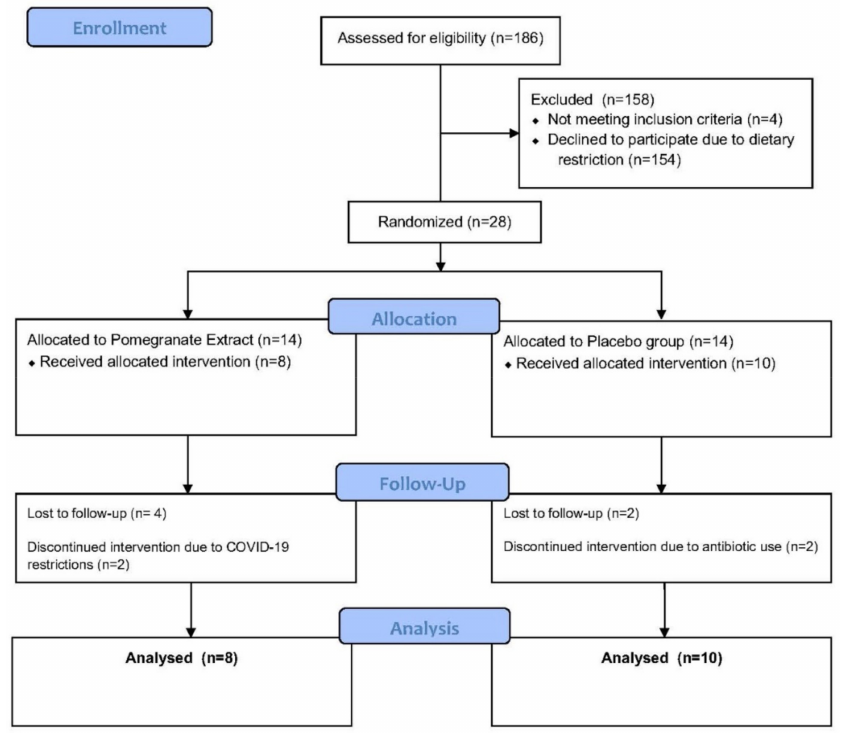
Figure 1. Consort Flow Diagram outlining the design of the randomized study evaluating the pomegranate extract compared against